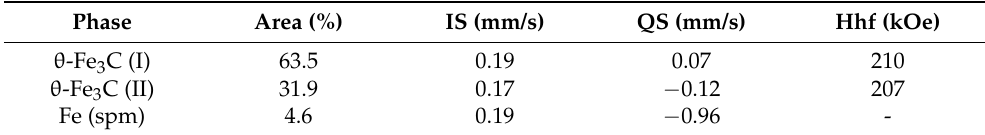
Figure 3. The structural identification of prepared single-phase θ -Fe 3 C sample. ( a ) XRD pattern. ( b ) MES spectra measured at room temperature. ( c , d ) Crystal structure. Table 3. Mössbauer parameters of the θ -Fe 3 C